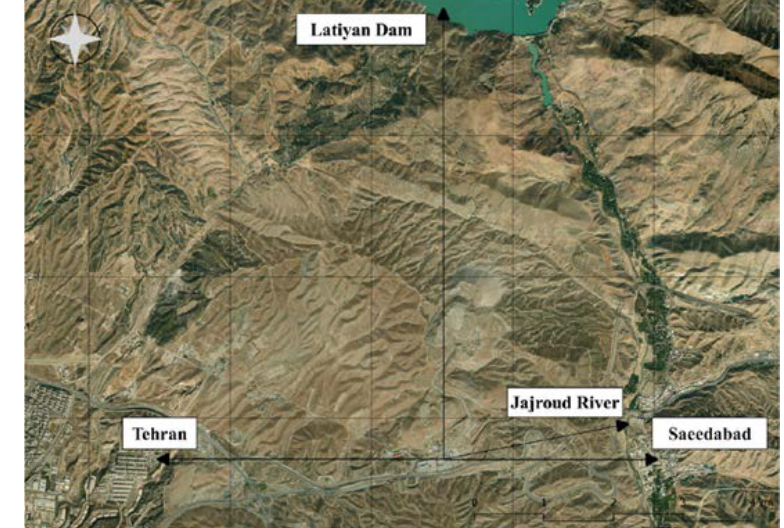
Fig. 2: The Aab’Ali landfill area and Fig. 2: The Aab'Ali landfill area and surrounding